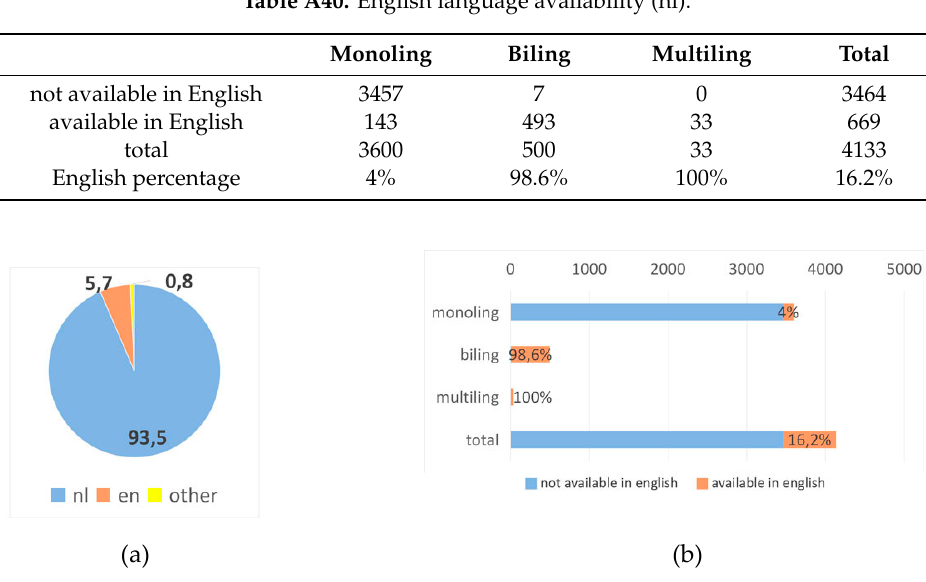
Table A41. Primary languages (pl).